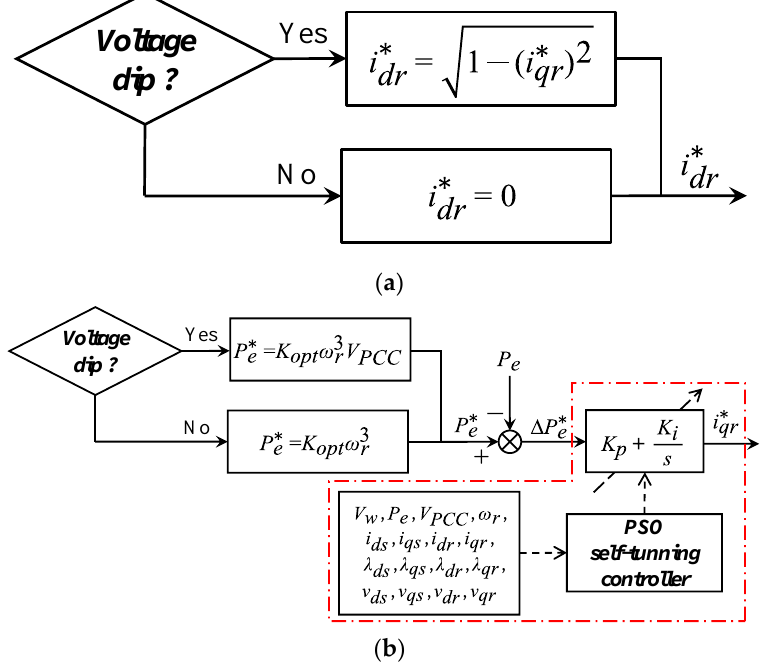
Figure 4. The proposed reactive and real power controller. ( a ) reactive power controller. ( b ) real power controller.